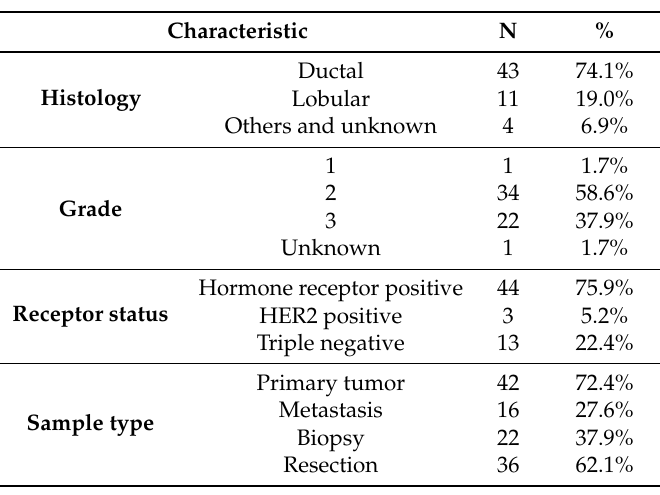
Table 4. Patient